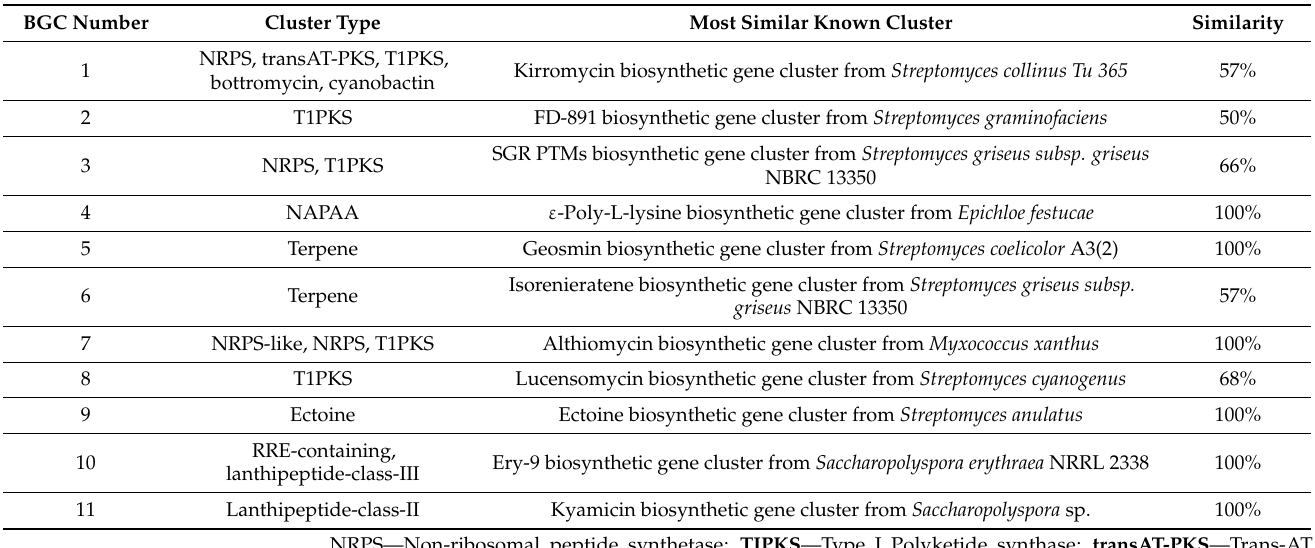
Table 1. Secondary metabolite gene clusters identified in the genome sequence of Saccharopolyspora sp. NFXS83. Only clusters with >50% similarity to known clusters are